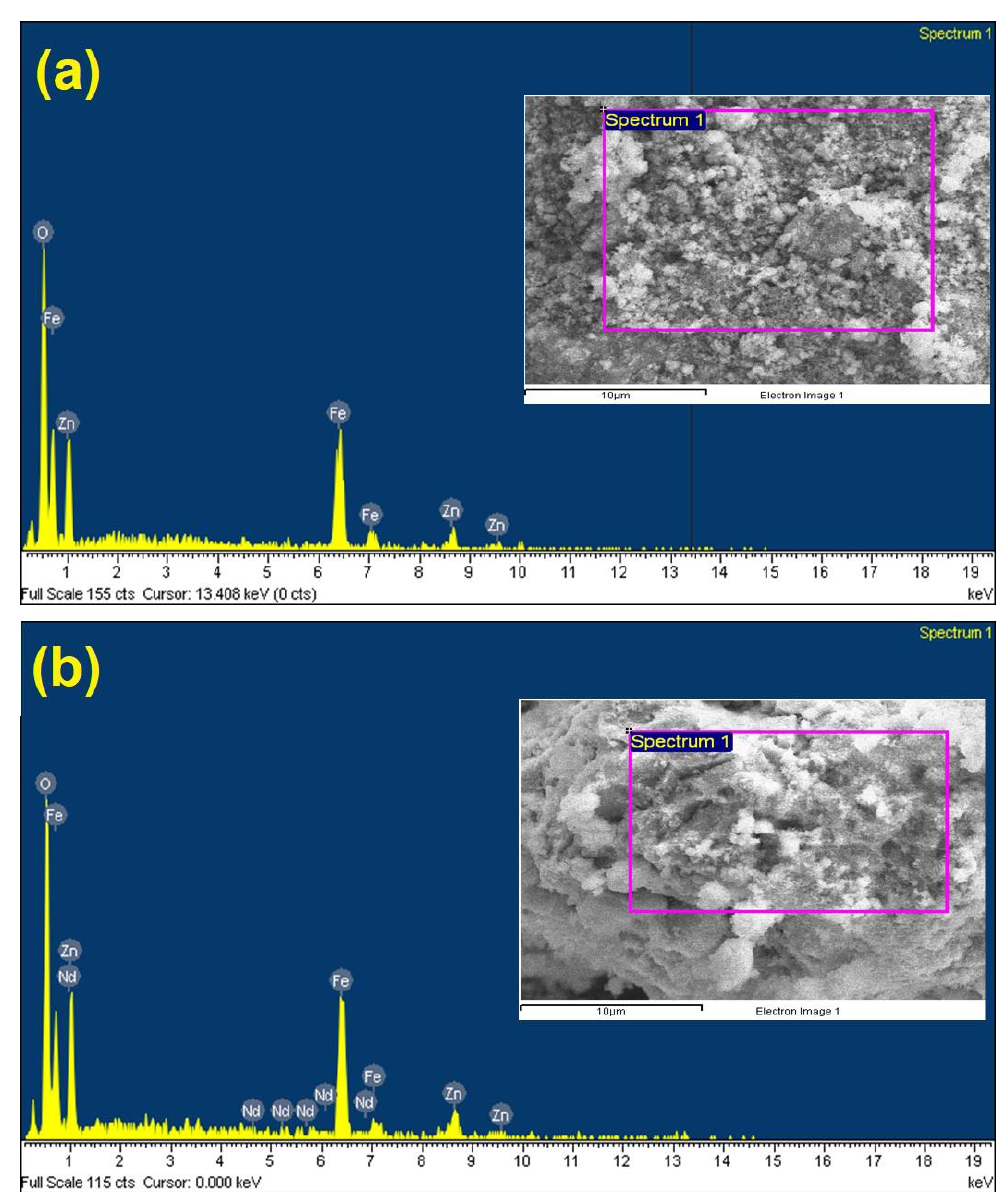
Figure 5. EDX spectra of ZnNd x Fe 2−x O 4 nanoparticles: ( a ) x = 0; ( b ) x = 0.03.